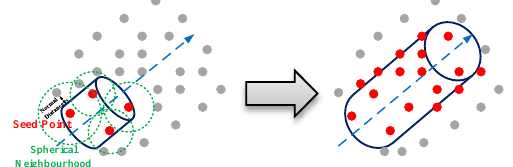
Figure 7. The region-growing procedure for the segmentation of pole-like features